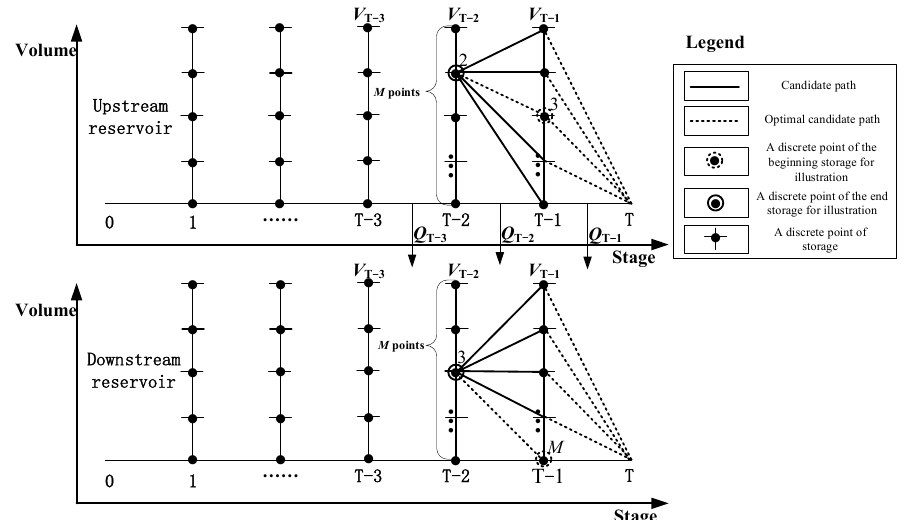
Figure 1. Flowchart of multidimensional DP in solving joint optimal scheduling of cascade reser ‐ voirs.